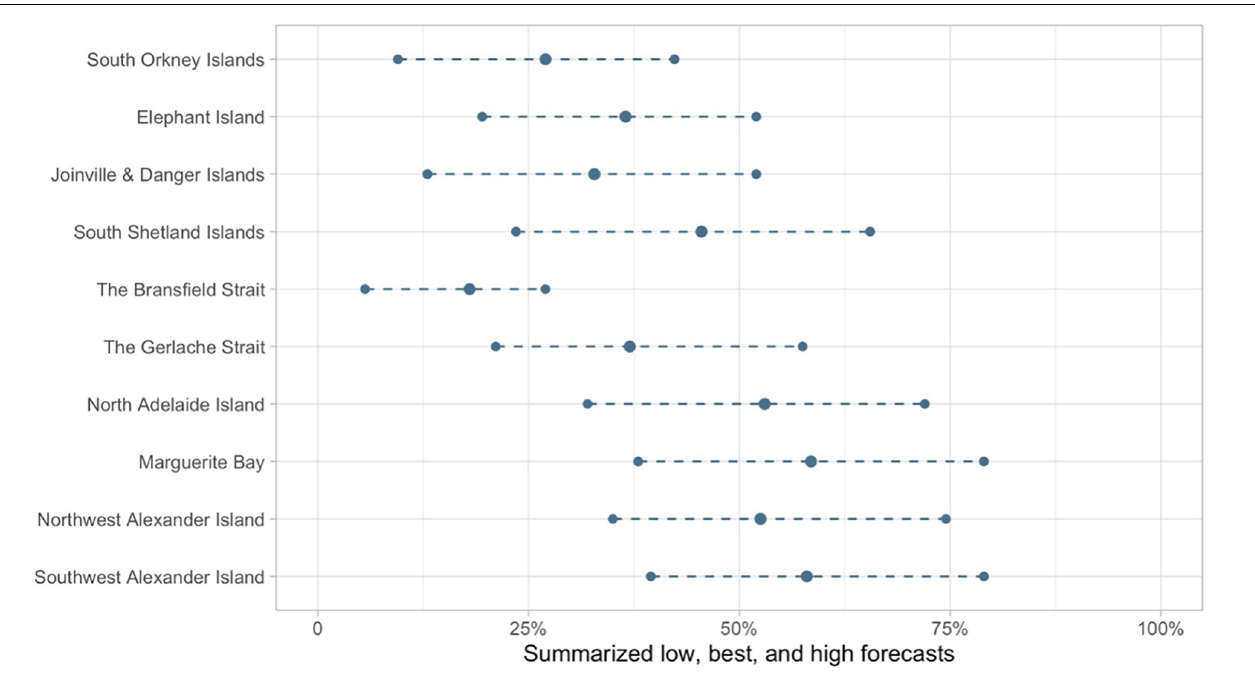
FIGURE 4 | Final quantitative forecasts of the likelihood of MPA designation – These forecasts represent three (low, best, high) separate arithmetic mean estimates of the likelihood that each area “is designated or included within a no-take (e.g., ‘general protection zone’) MPA within the next eight years.” The lower end, dot, and upper end of each line represent the low, best, and high estimates, respectively, rather than a single estimate with two other points representing the extent of its associated confidence interval. Here, the forecasts are arranged latitudinally (north to south) on the